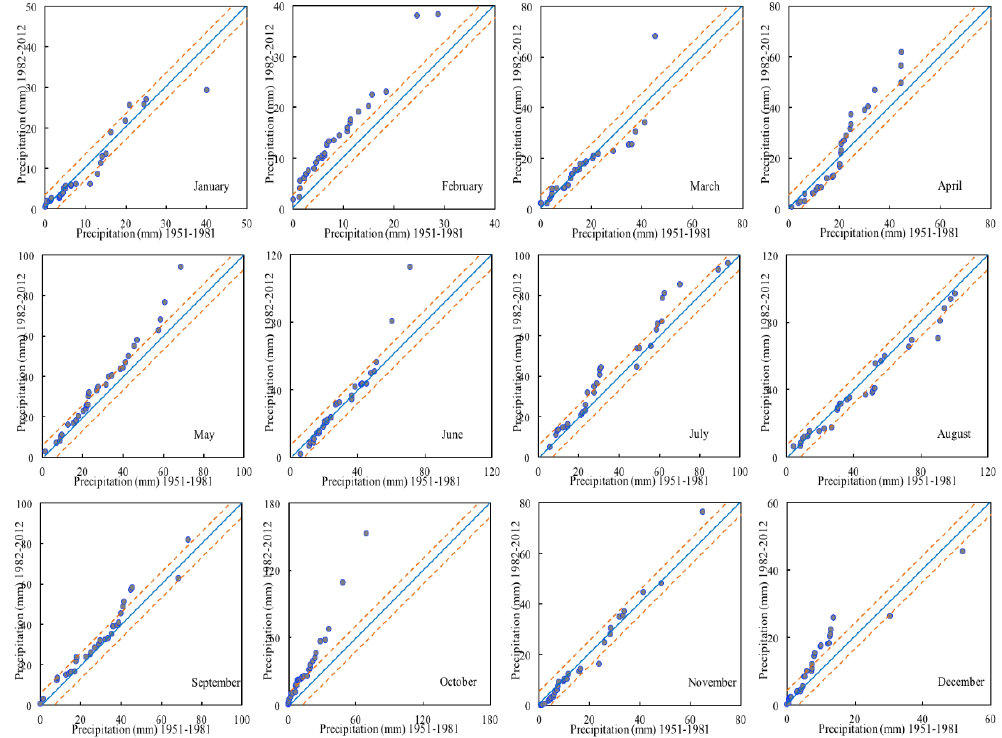
Figure 4. The results of the ITA method for monthly precipitation at the Cholpon-Ata station in the Lake Issyk-Kul basin 1951–2012.